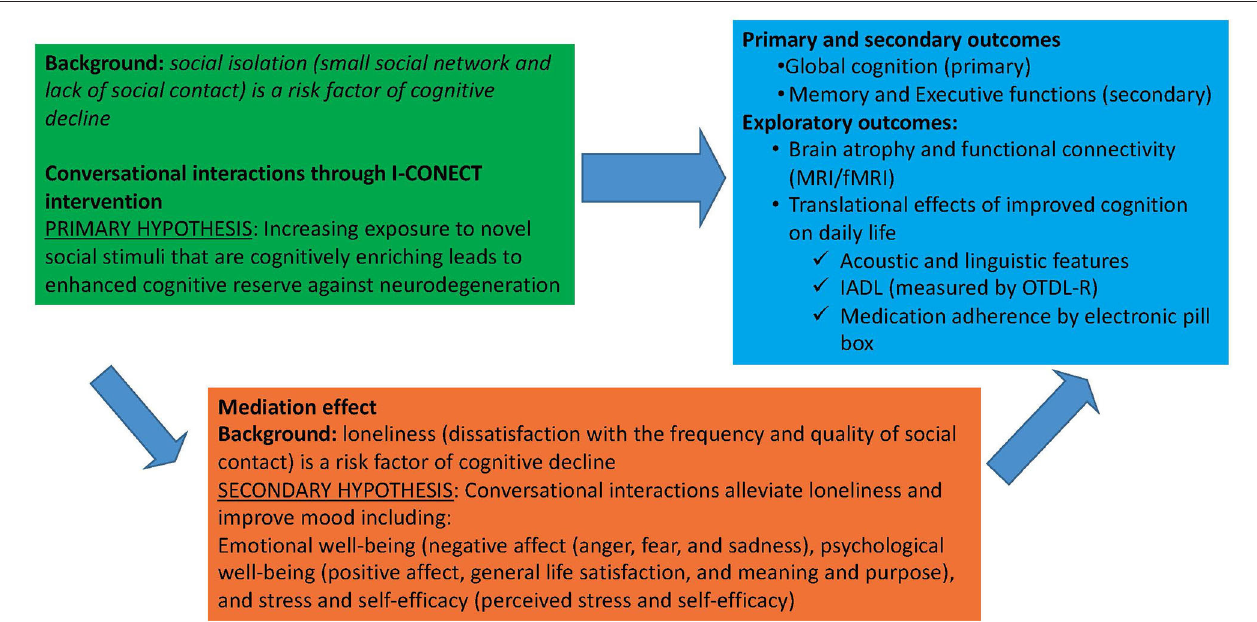
FIGURE 1 | I-CONECT project efficacy assessments: Direct effect of social interaction on cognition and mediating effects through psychological